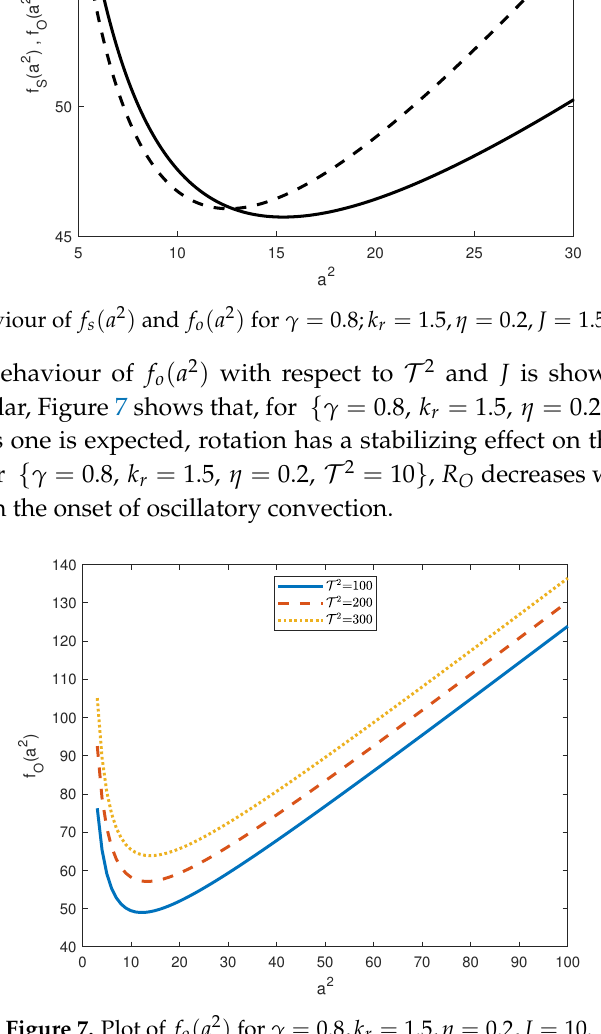
Figure 7. Plot of f o ( a 2 ) for γ = 0.8, k r = 1.5, η = 0.2, J =